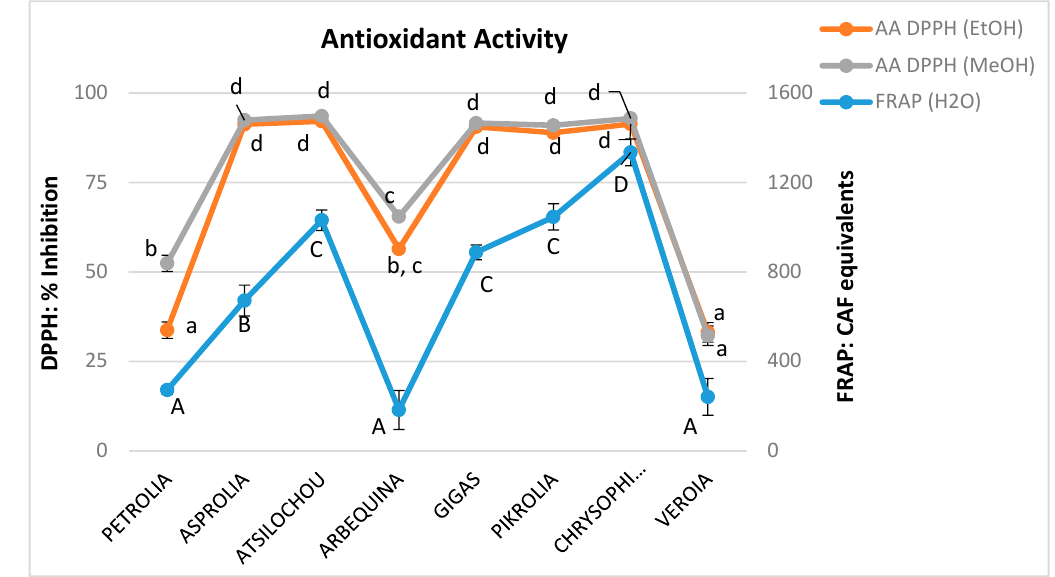
Figure 6. Antioxidant activity as determined via the 1,1-diphenyl-2-picrylhydrazyl (DPPH) assay, expressed as % DPPH radical scavenging inhibition for the methanol and ethanol extracts as well as ferric reducing capacity (FRAP), expressed as CAF equivalents (mg/L) for the respective aqueous extracts; different letters (a–d, A–D) indicate statistical significantly differences.